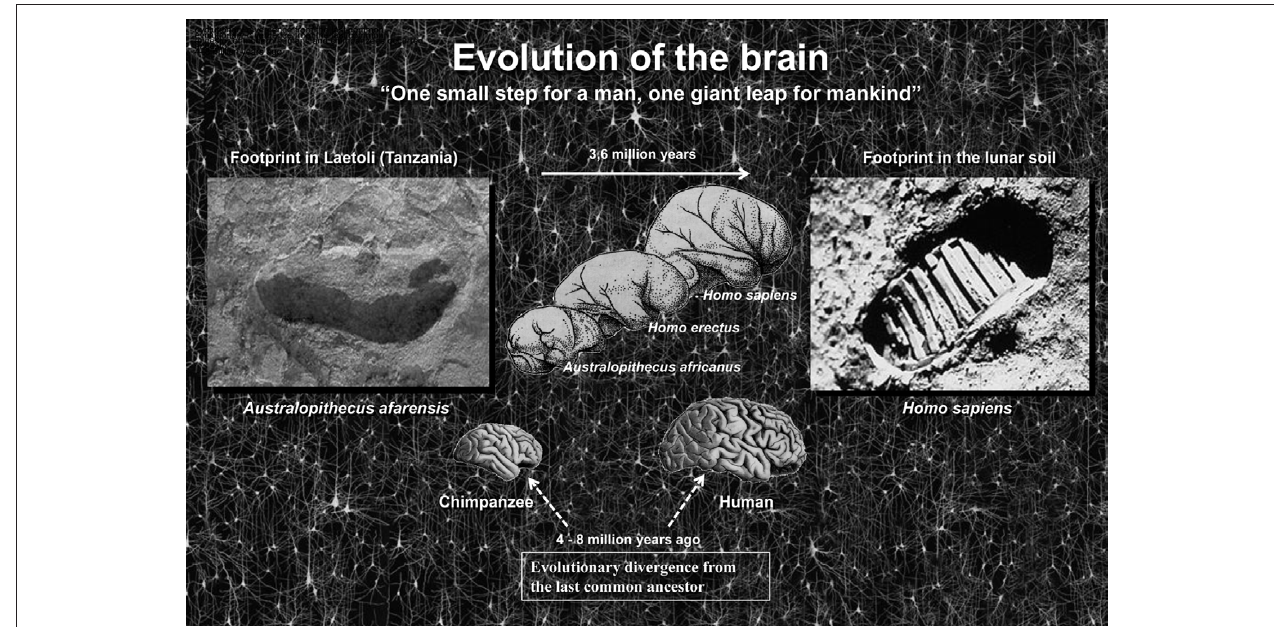
Figure 2 | One small step for a man, one giant leap for mankind (Neil Armstrong). Left, photograph of the footprint left approximately 3.5 million years ago by A. afarensis , probably the immediate predecessor of the genus Homo , in Laetoli (Tanzania). Right, footprint in the lunar soil made by the astronaut Neil Armstrong (Apollo 11, July 21, 1969), the first person ever to set foot on the Moon. In a relatively short period of time we have gone from